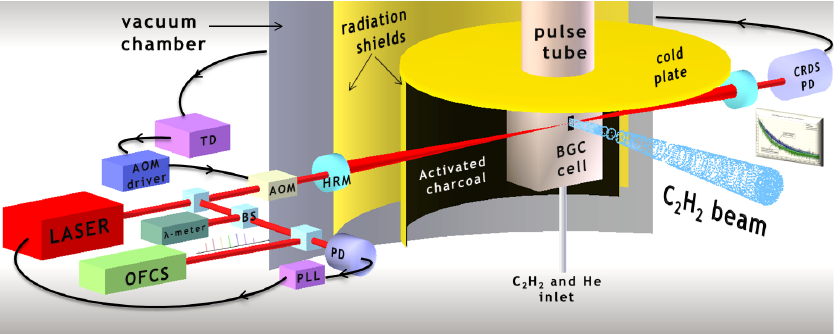
Figure 5. Layout of the experimental setup for OFC-assited cavity ring-down spectroscopy (CRDS) of a 10-K beam of acetylene, consisting of two main blocks: the buffer-gas-cooling (BGC) source and the laser spectromter. CRDS signals, measured at a distance of 1 cm from the BGC cell exit, exhibit signal-to-noise ratios exceeding 200, for injection fluxes of 8 (helium) and 4 (acetylene) SCCM (standard cubic centimeters per minute). Reprinted with permission from [114] © The Royal Society of